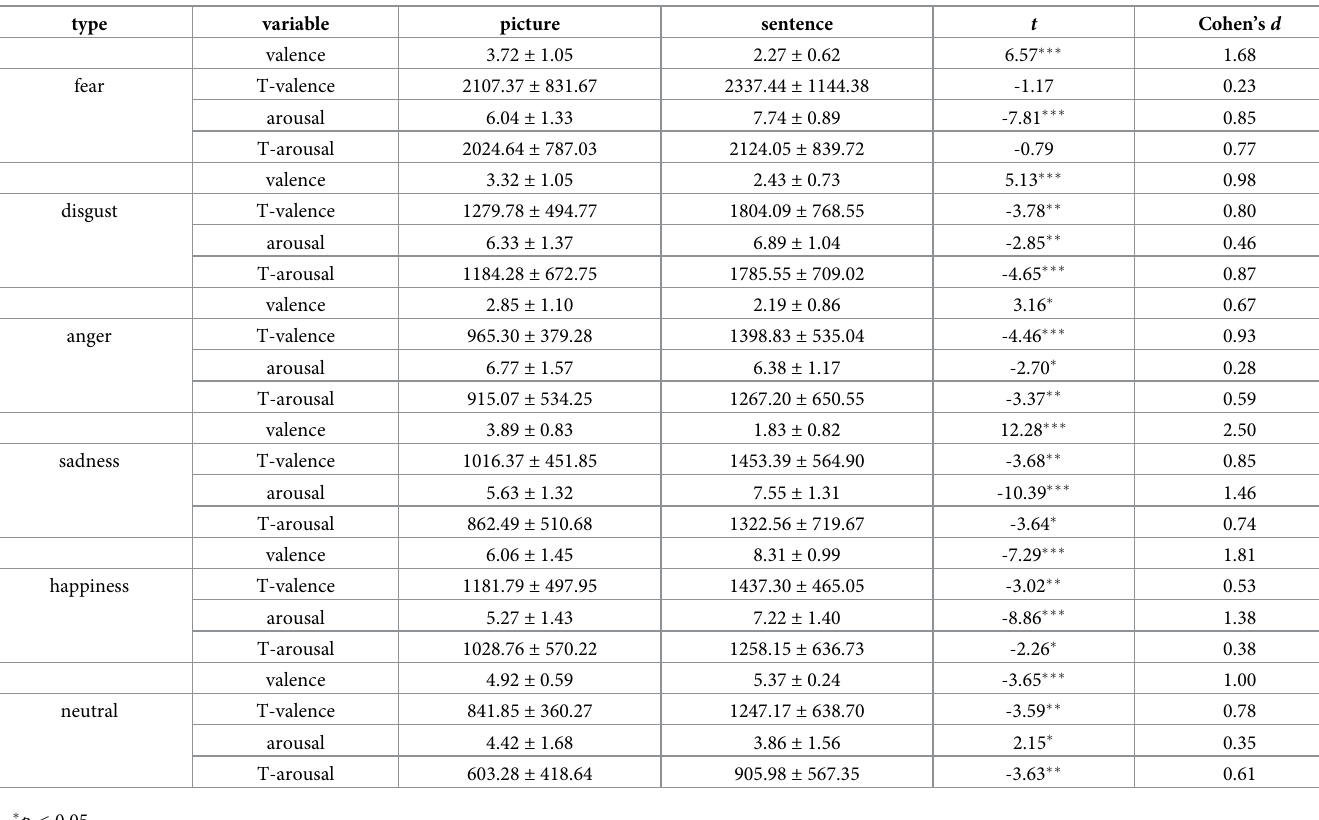
Table 2. Descriptive statistics of the different variables in seven emotions ( M ± SD